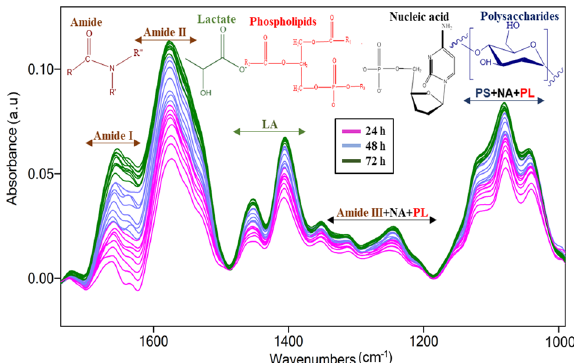
Fig. 6 IR-ATR spectra of L. parabuchneri bio fi lms monitored for 24, 48, and 72 h during real-time incubation within the fl ow system. The observed spectral changes correspond to proteins (amide I: 1700 – 1618 cm − 1 , amide II: 1585 – 1486 cm − 1 ), LA: 1465 – 1293 cm − 1 , amide III + NA + PL: 1350 – 1180 cm − 1 and PS + NA + PL: 1189 – 960 cm − 1 , respectively (LA = lactic acid or lactate, NA = nucleic acids, PL = phospholipids, PS =